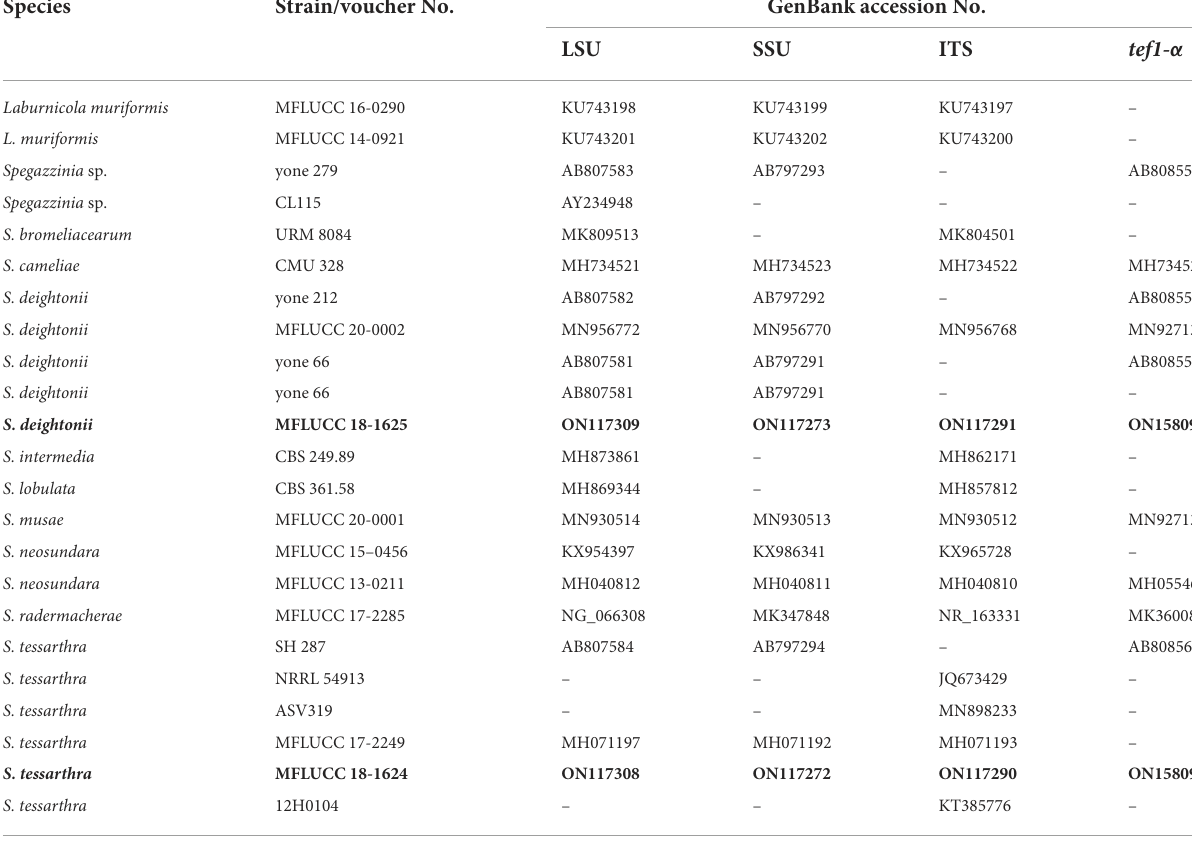
TABLE 4 GenBank and culture collection accession numbers of species included in this phylogenetic study ( Spegazzinia tree). Species